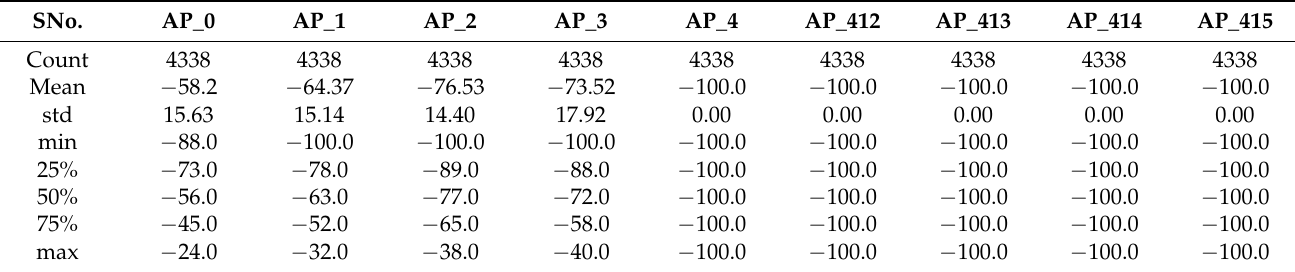
Table 3. The distribution and descriptive measures of the Online RSS